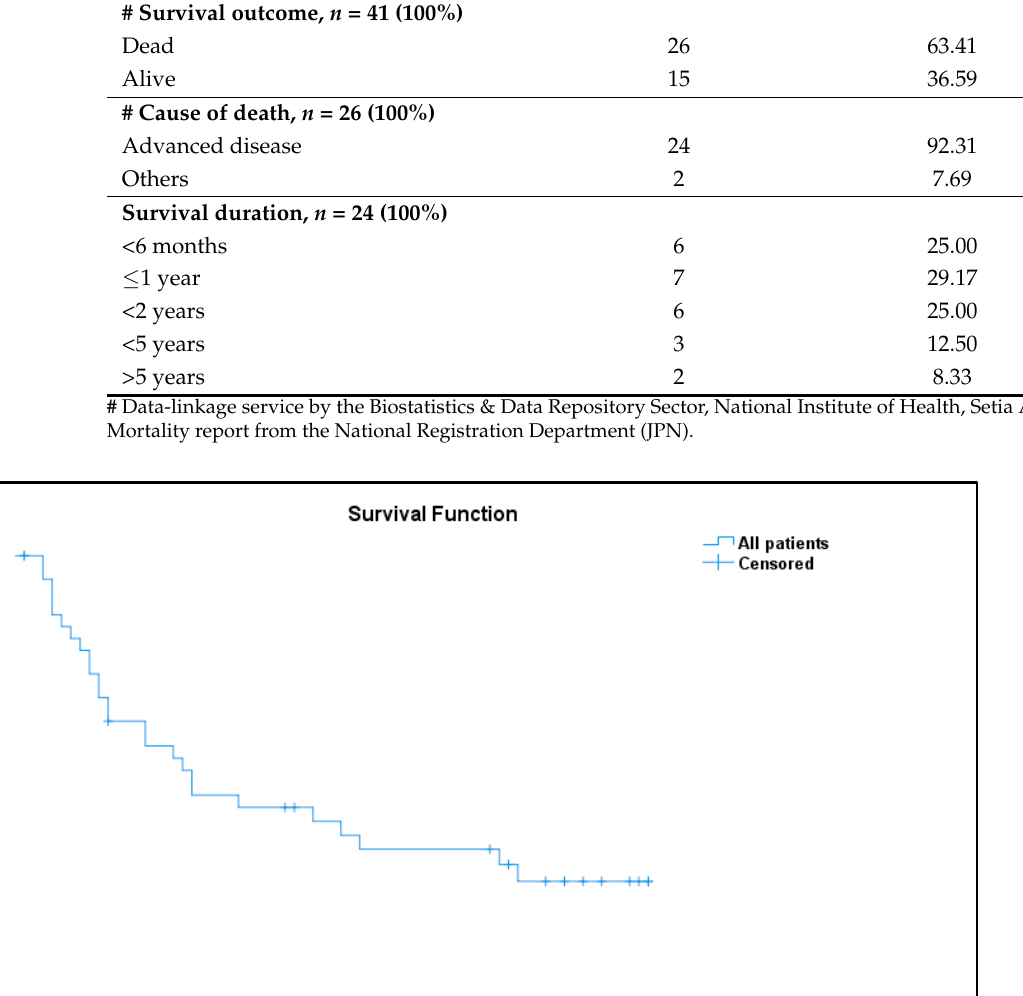
11 Figure 4. Protein interaction of significantly dysregulated genes. Protein–protein interaction and cluster analysis of the five differentially regulated genes from human T-helper cell differentiation array generated using the STRING Consortium 2022 software (version 11.5 ). There were five nodes and three edges. The PPI enrichment was found to be statistically significant ( p < 0.000157). 3.7. Patient Prognosis Out of 41 patients, 26 patients (63.41%) have passed away, out of which 24 (92.31%) died due to advanced disease, and two (7.69%) died due to other causes. Fifteen patients